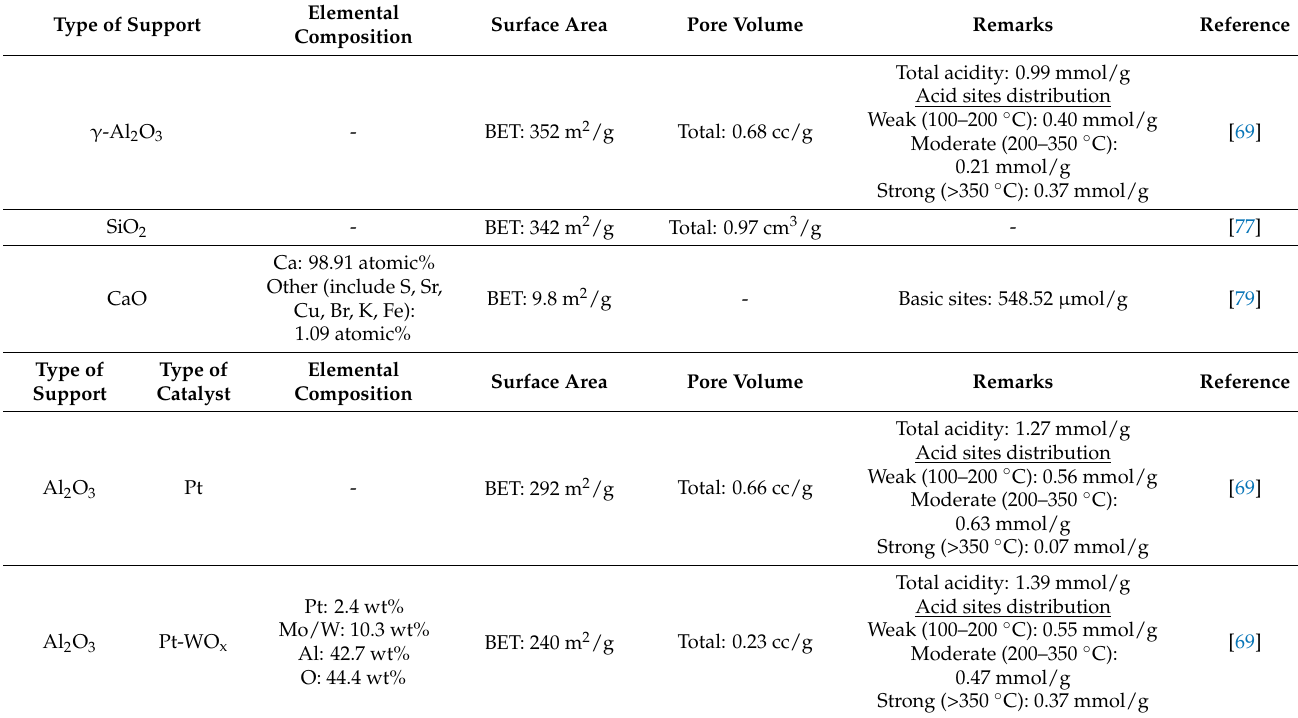
Table 3. Metal oxide as catalyst support for renewable diesel